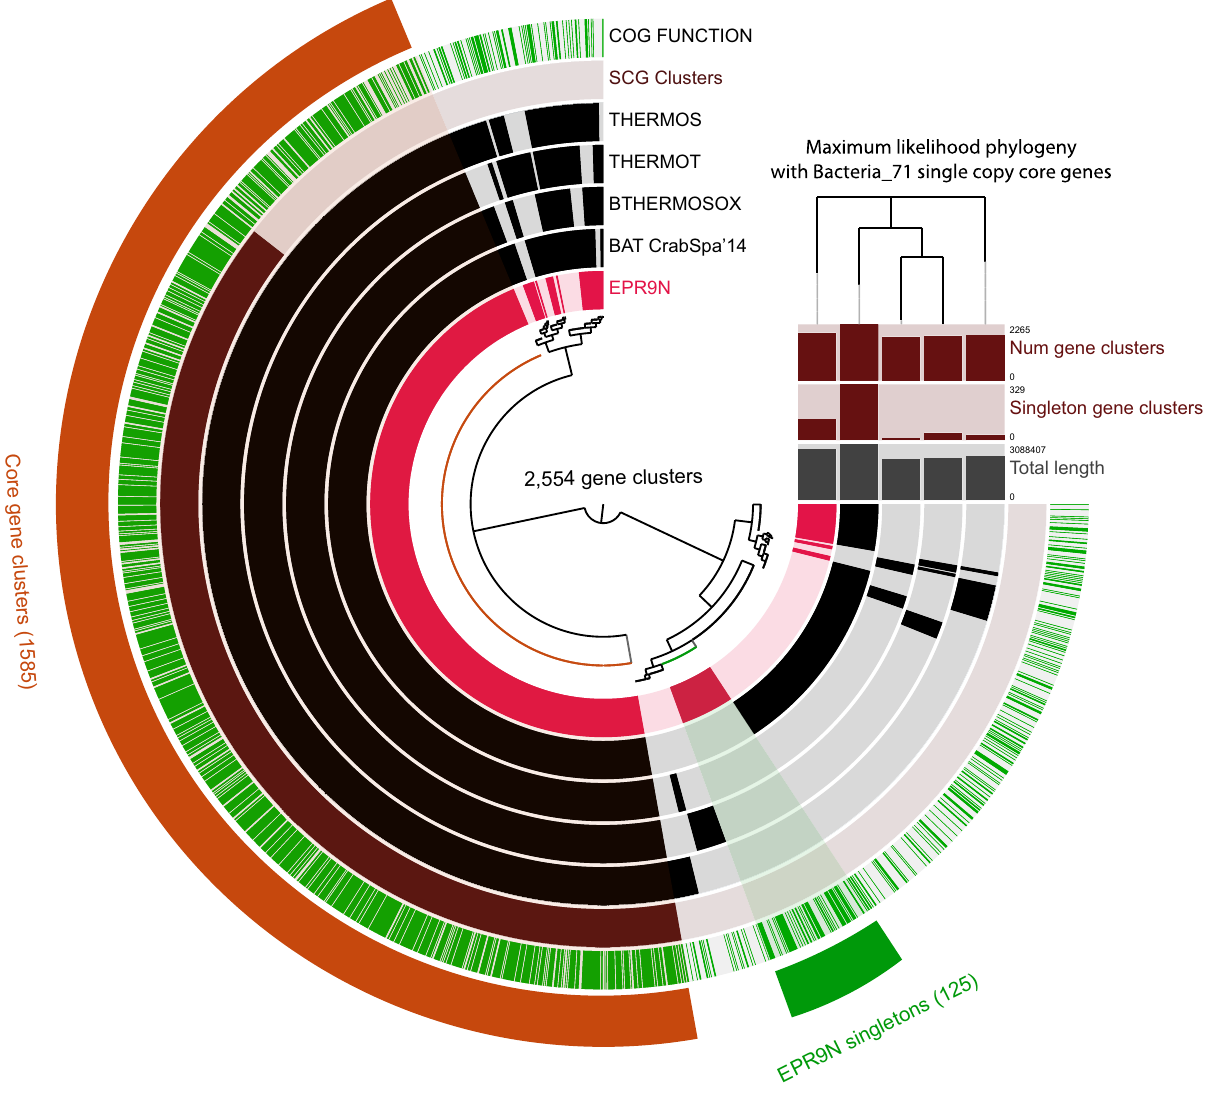
Figure 2. Pangenomic comparison of B. thermophilus thiotrophic symbiont genomes. The inner dendrogram shows hierarchical relationships among these clusters based on their distribution across genomes. Within layers, dark colors indicate the presence of a gene cluster, while light colors indicate absence. Different gene cluster groups and their abundances are highlighted outside the pangenome graph, including core gene clusters among all B. thermophilus symbiont genomes (red) and EPR9N symbiont strain specific gene clusters